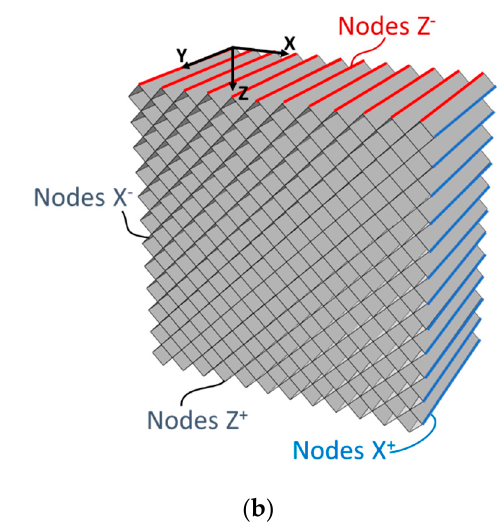
Figure 3. ( a ) T45 and ( b ) R20 explicit models. Table 3. Onyx engineering constants used in the simulations.